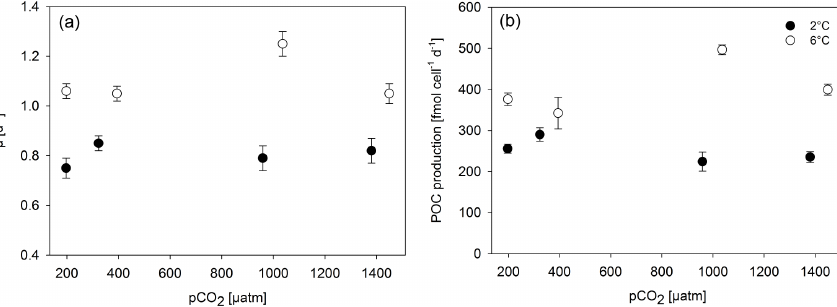
were 8.30 ± 0.01, 8.04 ± 0.01, 7.65 ± 0.01 and 7.52 ±